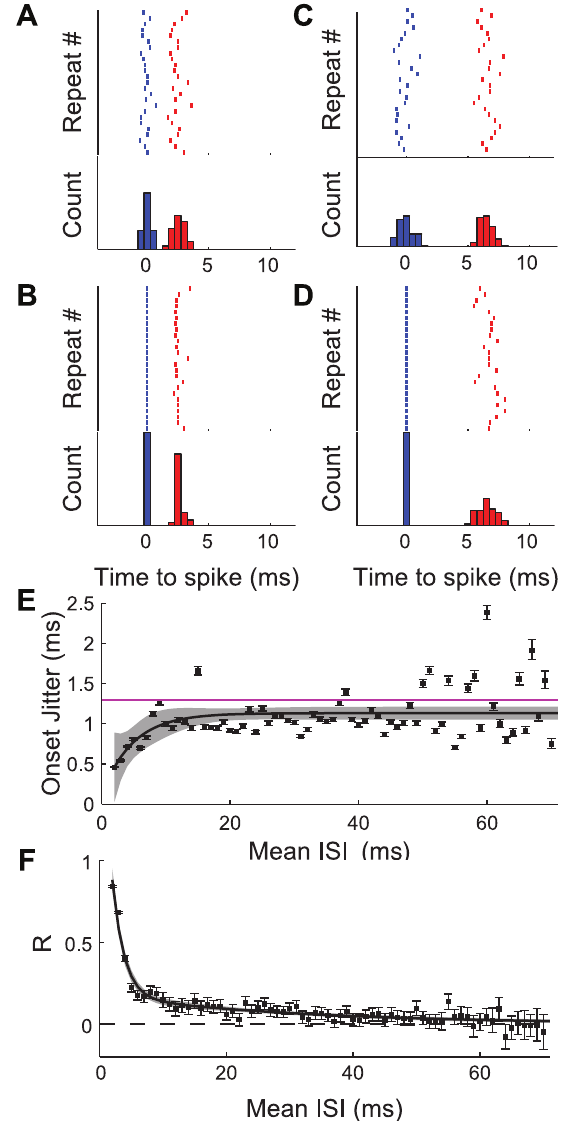
Figure 2. Spike-spike interactions in doublet patterns recorded in cricket interneurons. A, Upper trace: A raster plot showing 25 of 85 responses to repeated presentations of a GWN stimulus, recording from the same cell as shown in Figure 1. The cell consistently responded to the stimulus by firing a doublet (first spike shown in blue, second spike in red) with average ISI of 2.6 ms. A, Lower trace: PSTH of all 85 responses from the raster, with the color convention conserved. B, upper and lower traces: Raster plotandPSTHshowingsame data fromA, here alignedrelative tothe time of the first spike in the doublet (t=0) rather than to the timing of the stimulus. This shows the variability in ISI across presentations of a single stimulus. C and D: Data from a second doublet event (mean ISI=6.5 ms, 73 responses) from the same interneuron, data presentation conserved. E: jitter ofarrivaltime of first spike inrepeatabledoublets recorded from40different cells in 32 animals, as a function of ISI (7753 events composed of 197,601 total pairs of spikes). Black line shows model fit to data (Eq. 1), with shaded area representing 95% confidence envelope around predictions from the model. Horizontal purple line shows population mean of single spike jitter fromfrozennoisemethod.F:estimateofcorrelationcoefficientbetweenfirst and second spikes in repeatable doublets (from same data set as in E). Error barsrepresent95%confidencelimitsonestimationofcorrelationcoefficient. SolidblacklineshowscorrelationcoefficientasafunctionofISImodeledasa double exponential (Eq. 2), with 6 95% confidence interval on predictions from the model shown by the shaded grey region.